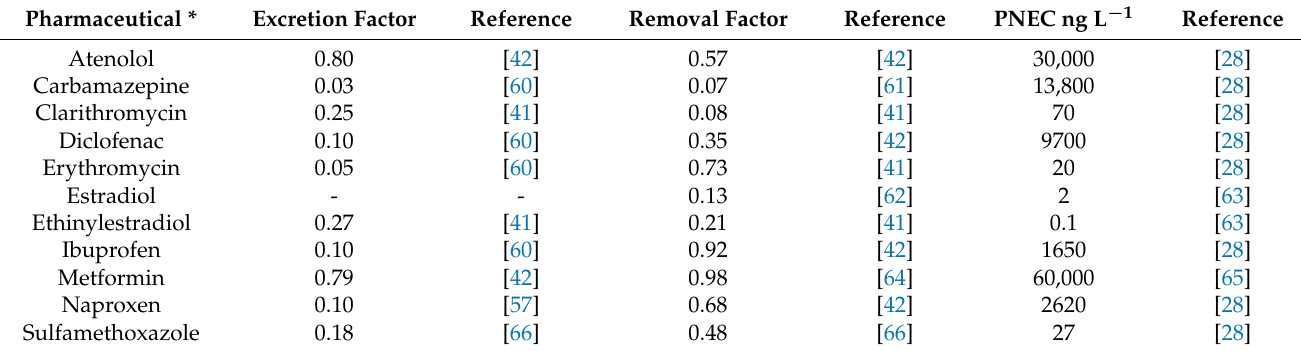
Table 2. Excretion and removal factors and predicted no-effect concentration (PNEC) of selected